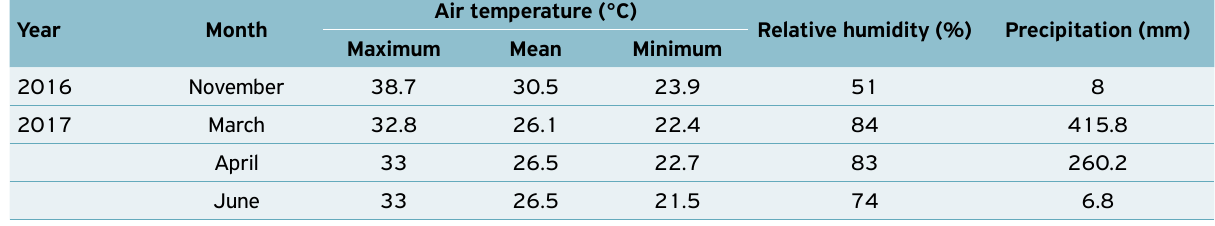
Table 2. Mean monthly temperature, relative humidity, and precipitation data recorded at an automatic meteorological station in the city of Teresina, Piauí,